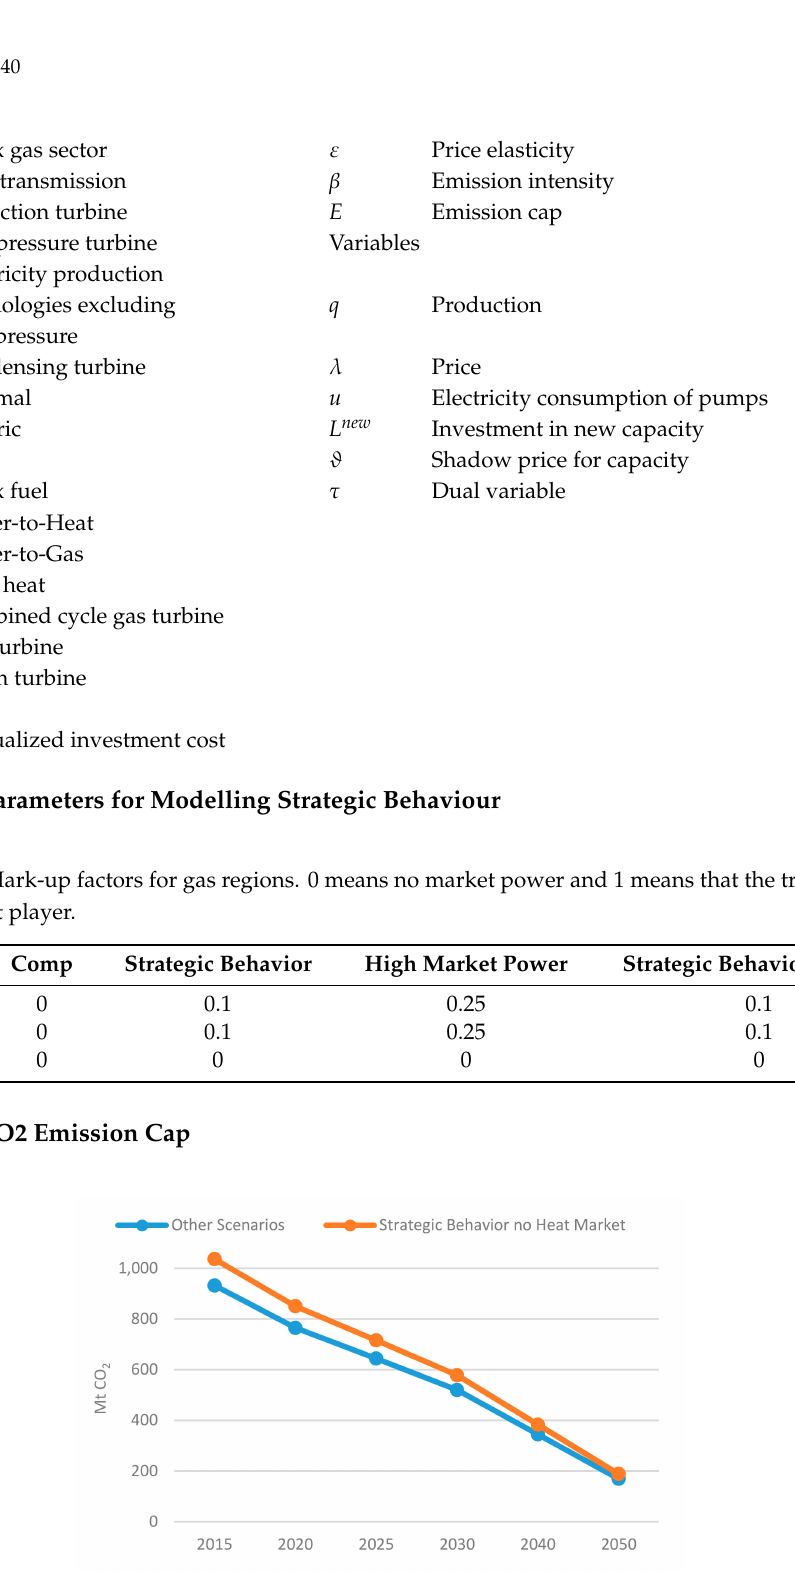
Figure A1. Developments of emission cap for the electricity